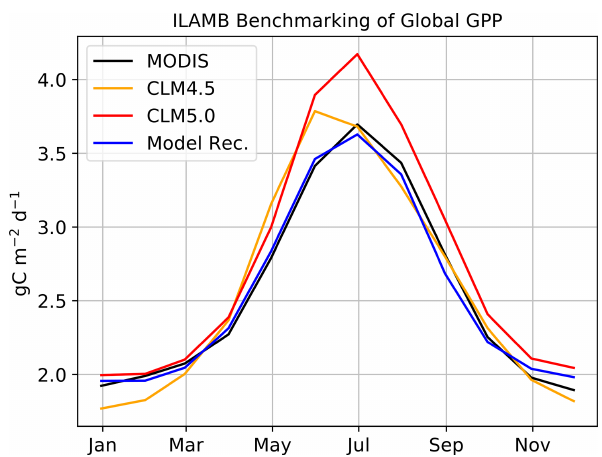
Figure 6. Seasonal global GPP benchmarked in ILAMB. Our model recommendation for the ABZ is applied globally and benchmarked for GPP in CLM4.5 and